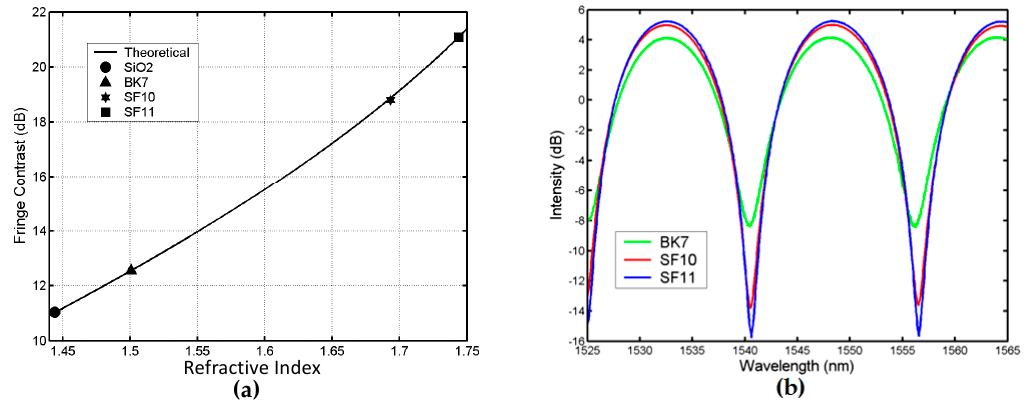
Figure 8. ( a ) Theoretical variation of the fringe contrast versus RI and experimental fringe contrasts of the measured samples; ( b ) Reflection spectra of the sensor for measured samples of BK7, SF10, and SF11, respectively. Copyright (2010) Applied Optics, from Reference [52].